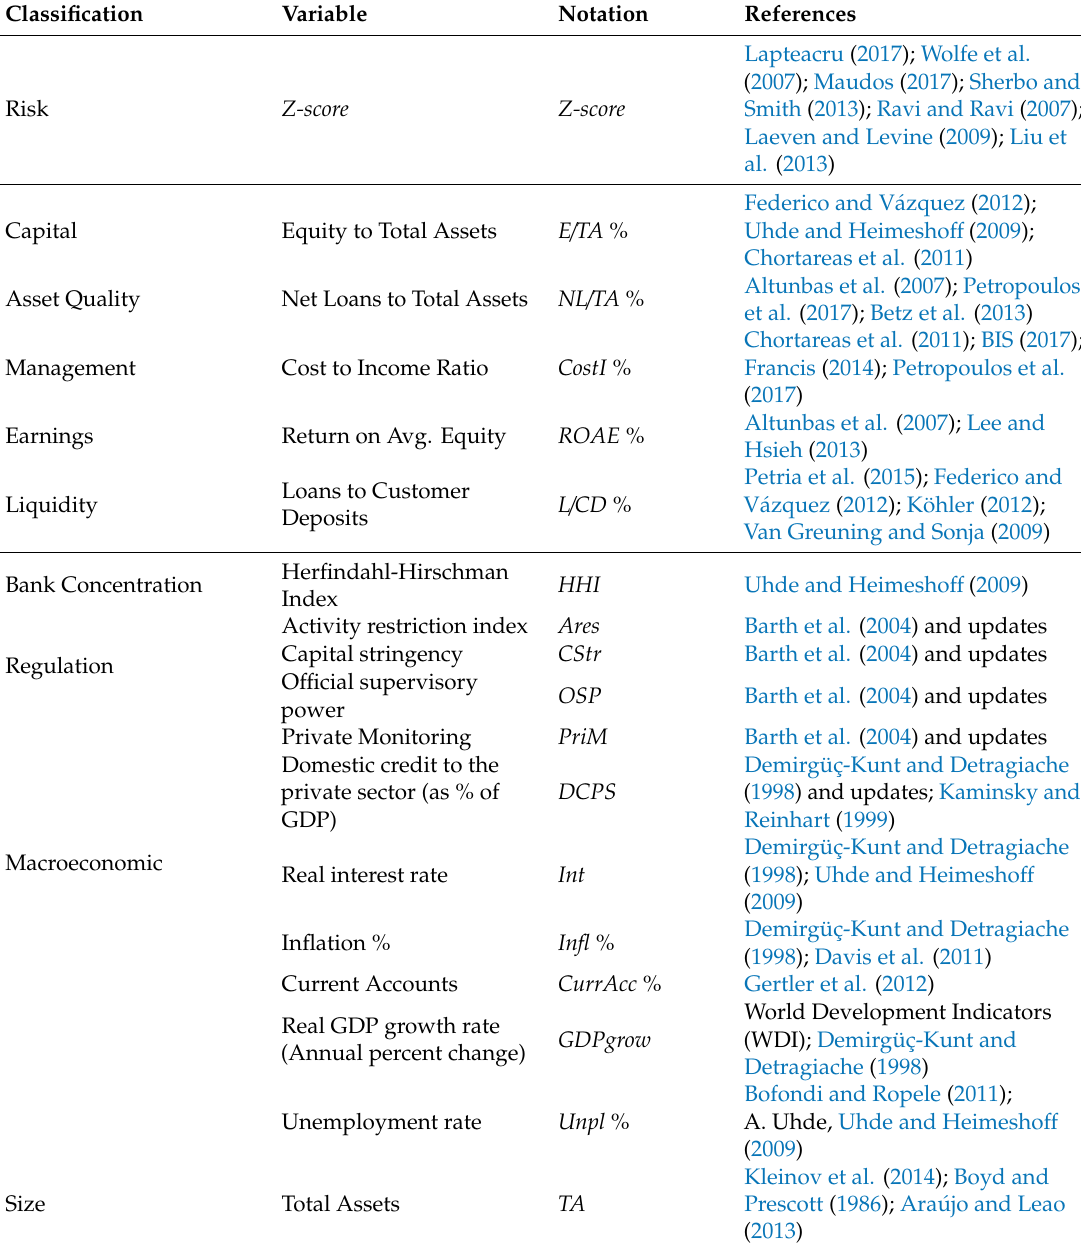
Table 2. Variable